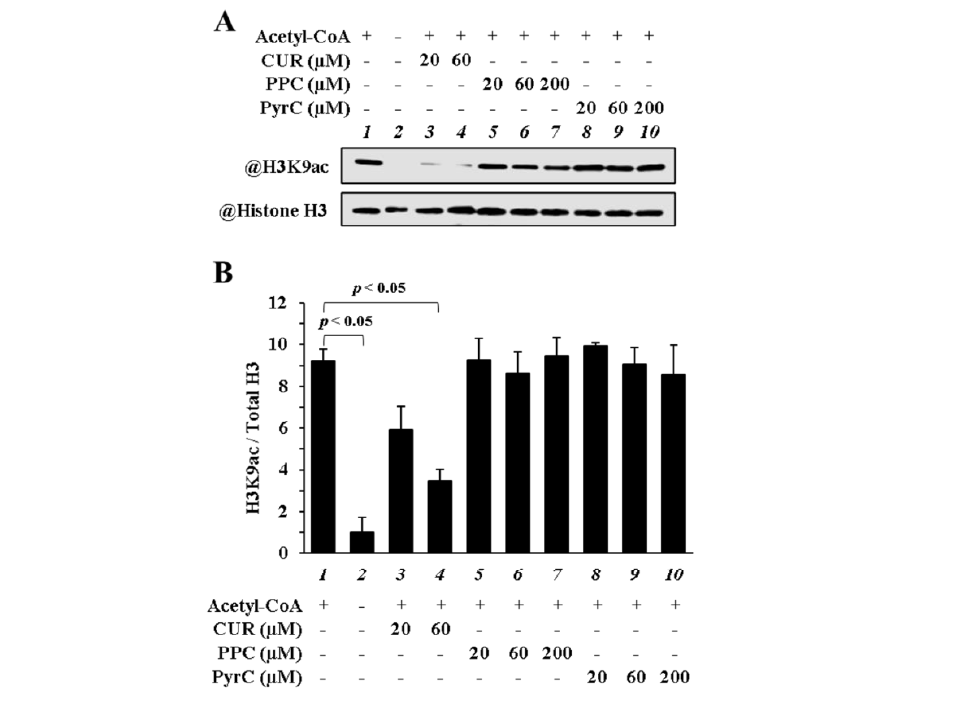
Figure 3. PyrC did not inhibit p300-HAT activity in vitro. ( A , B ) In vitro p300-HAT assay was performed using recombinant p300-HAT, histones, CUR (20, 60 µ M), PPC (20, 60, 200 µ M), and PyrC (20, 60, 200 µ M). These acetylation levels of histone were examined by Western blotting. ( A ) Photograph of a representative Western blot. ( B ) Quantifications of ( A ). N = 3.